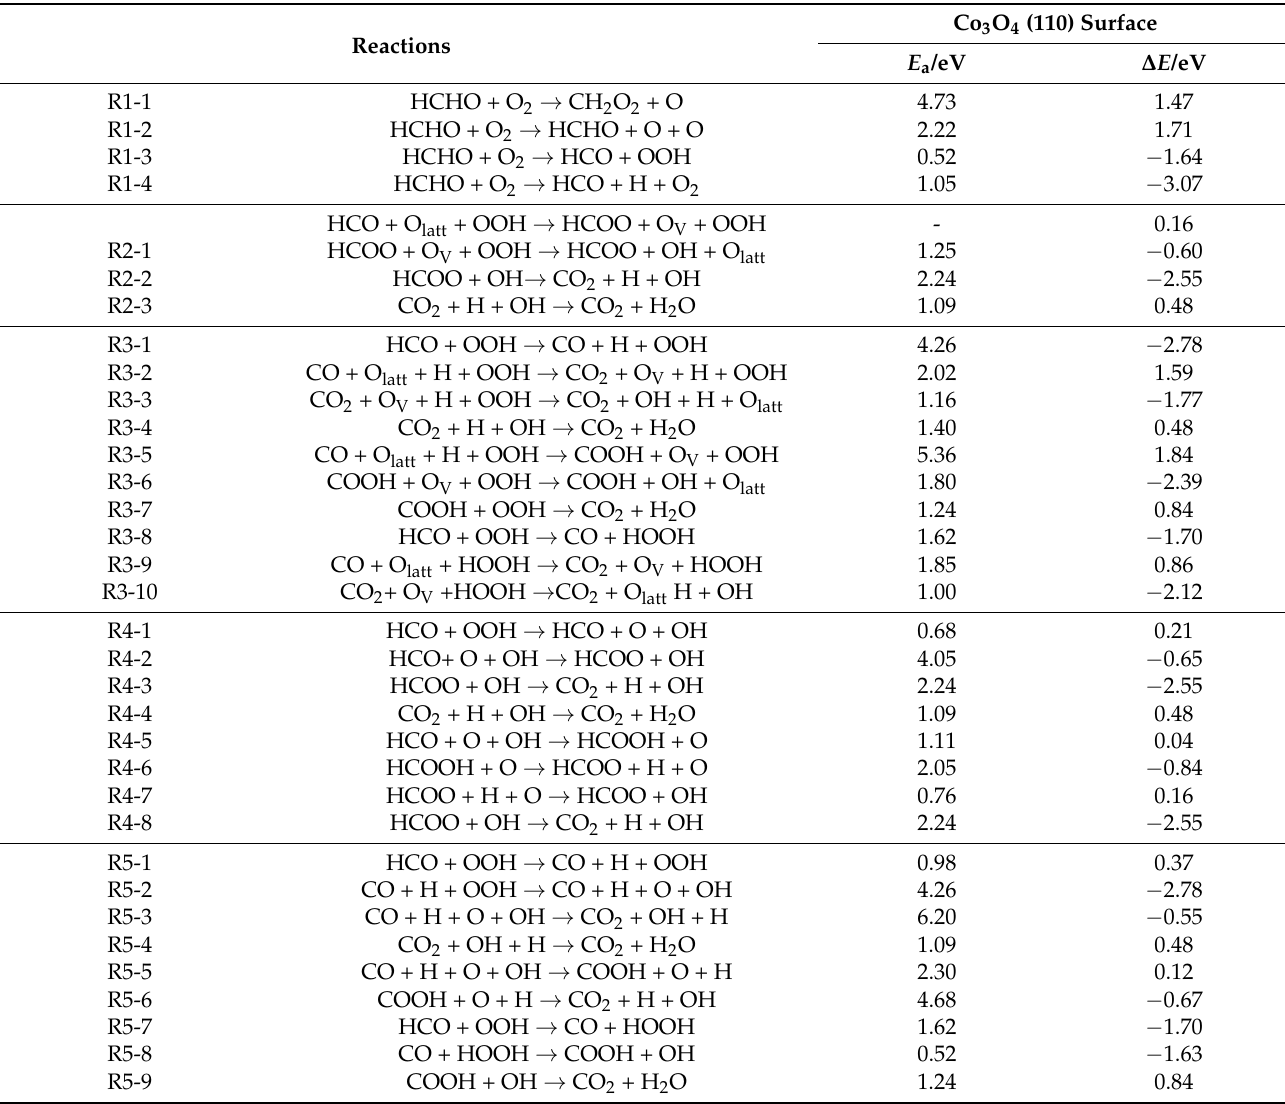
Table 2. All possible elementary reactions with the corresponding activation barriers ( E a /eV) and reaction energies ( ∆ E /eV) involved in HCHO oxidation on Co 3 O 4 (110) surface.